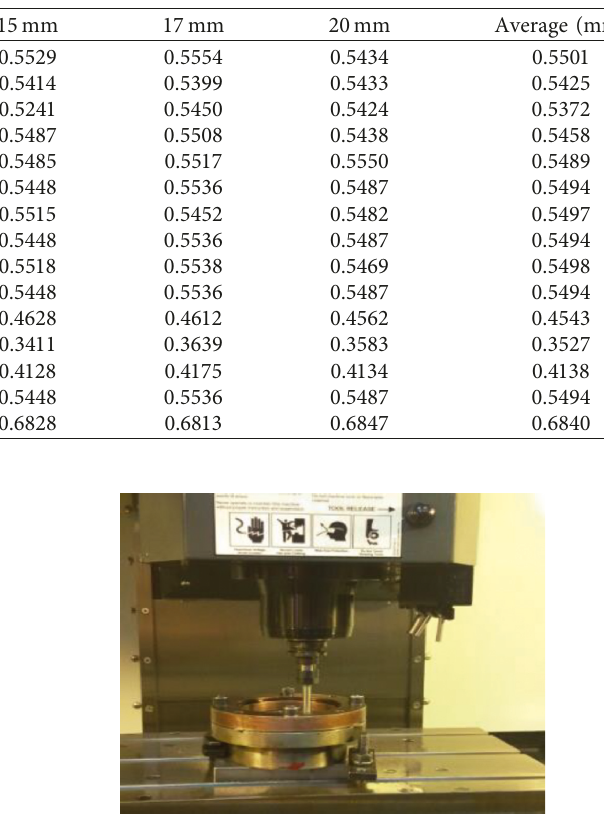
Figure 8: SPIF experiment unit.